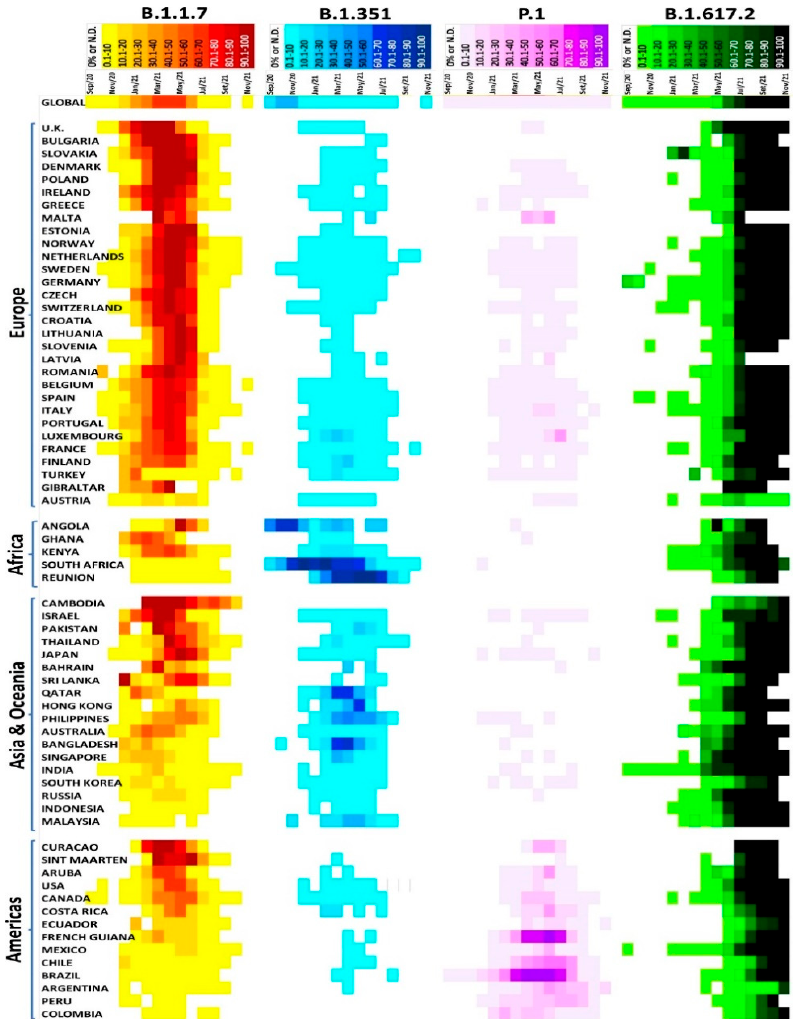
Figure 5. SARS-CoV–2 variants of concern distributed in several countries [104]. All viruses accumulated mutations during their evolution. The speed of mutation accumulations and the outcomes of transmission and disease symptoms in the host may depend on many factors, such as rate of mutations, immunity, the presence of other viral factors and viral dynamics inside the host or between different individuals. SARS-CoV-2 may have a lower mutation rate in comparison to other RNA viruses, such as HIV virus or influenza. The viruses of SARS-CoV-2 that were VOCs exhibited twice as many mutations in comparison to non-VOCs. VOCs may accumulate several mutations in spike